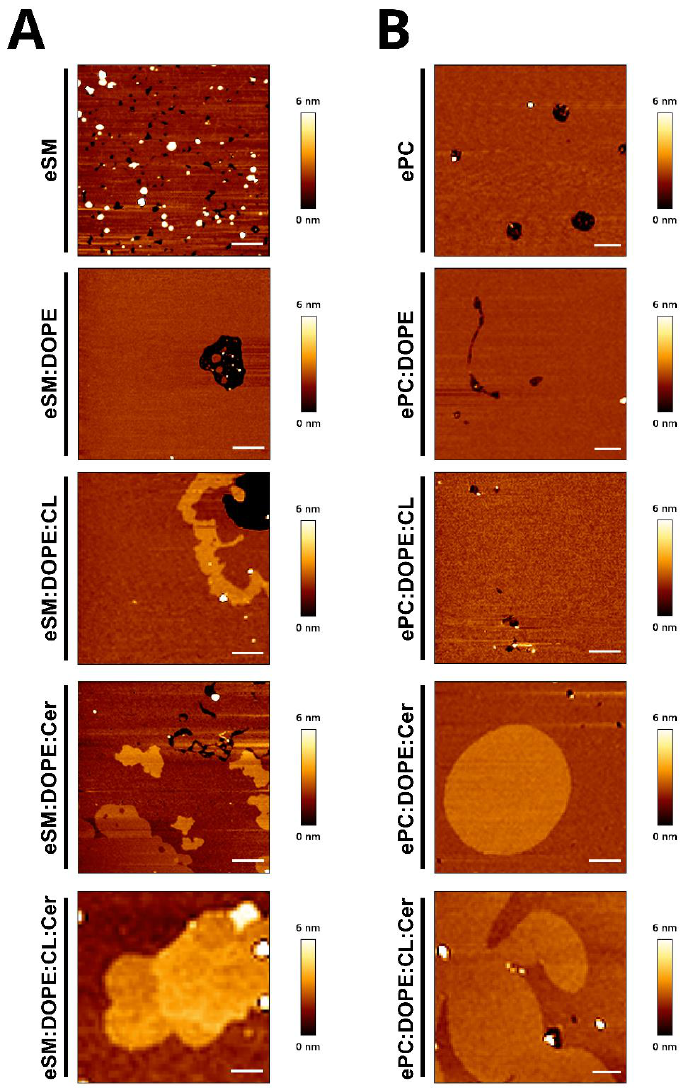
Figure 4. AFM topology of different lipid mixtures. eSM-based samples ( A ) and ePC-based samples ( B ). 3 µm × 3 µm images, scale bar = 500 nm. Representative images of three independent prepara- tions.